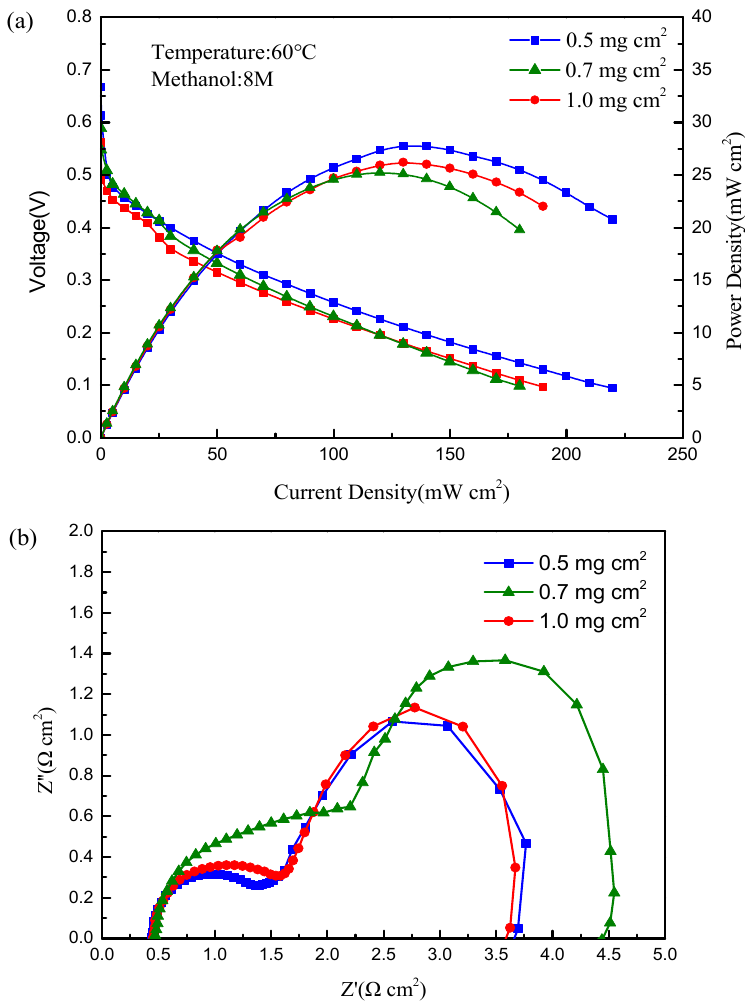
Figure 10. Comparison of electrodes with different GA loads at 8 M; ( a ) curves of polarization ( b ) EIS images.